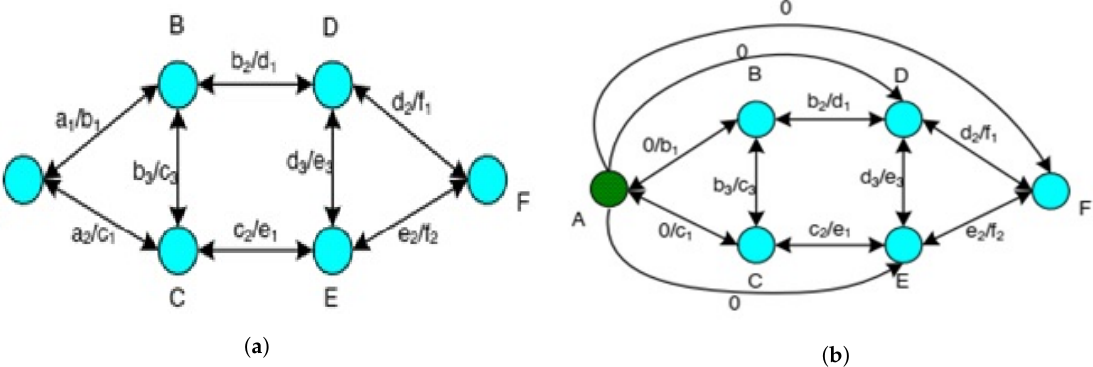
Figure 3. The network topology in homogeneous and heterogeneous wireless communication: ( a ) topology in homogeneous scenario; and ( b ) topology in heterogeneous scenario.